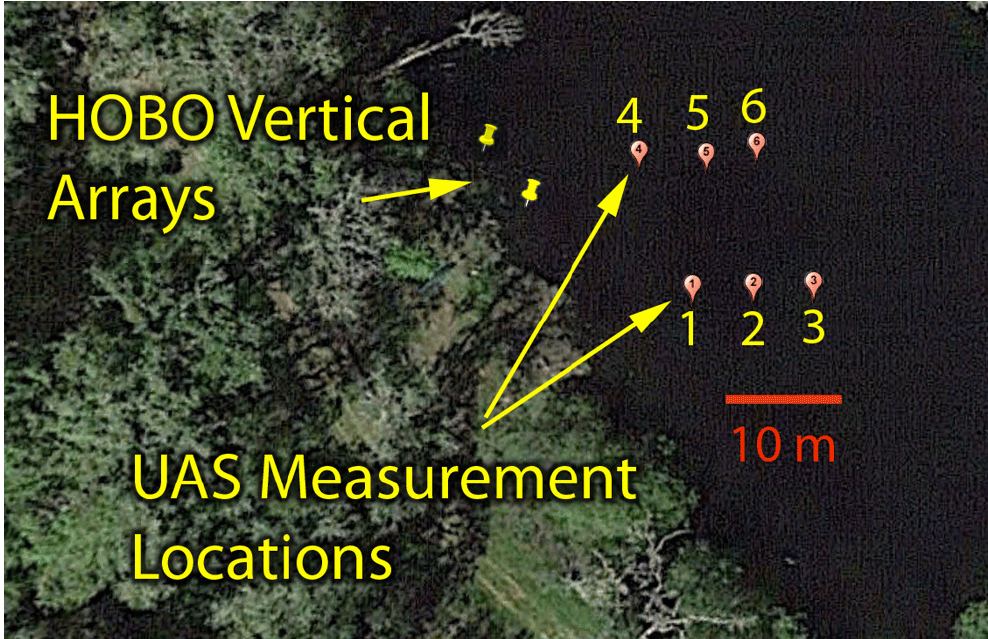
Figure 3. Locations of vertical profile measurements made by the UAS at Big Lake, Blue Oak Ranch Reserve, California,